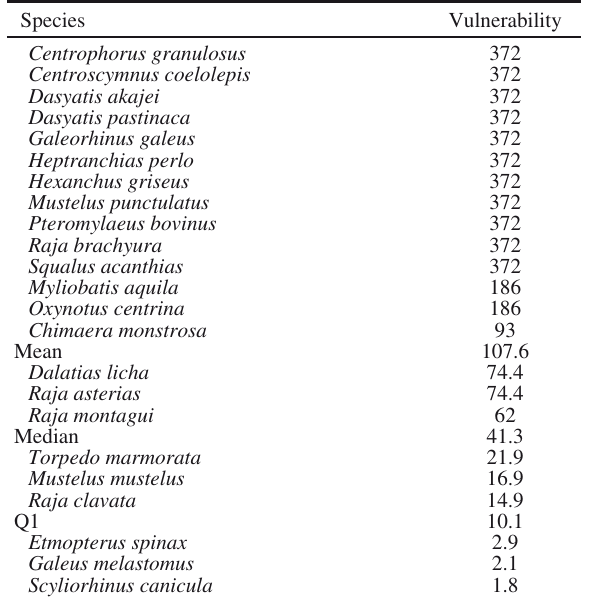
Table 3. – Vulnerability of the local populations of the cartilaginous fish species, with the mean, median and first quartile of vulnerabil- ity of the 299 species caught in the area